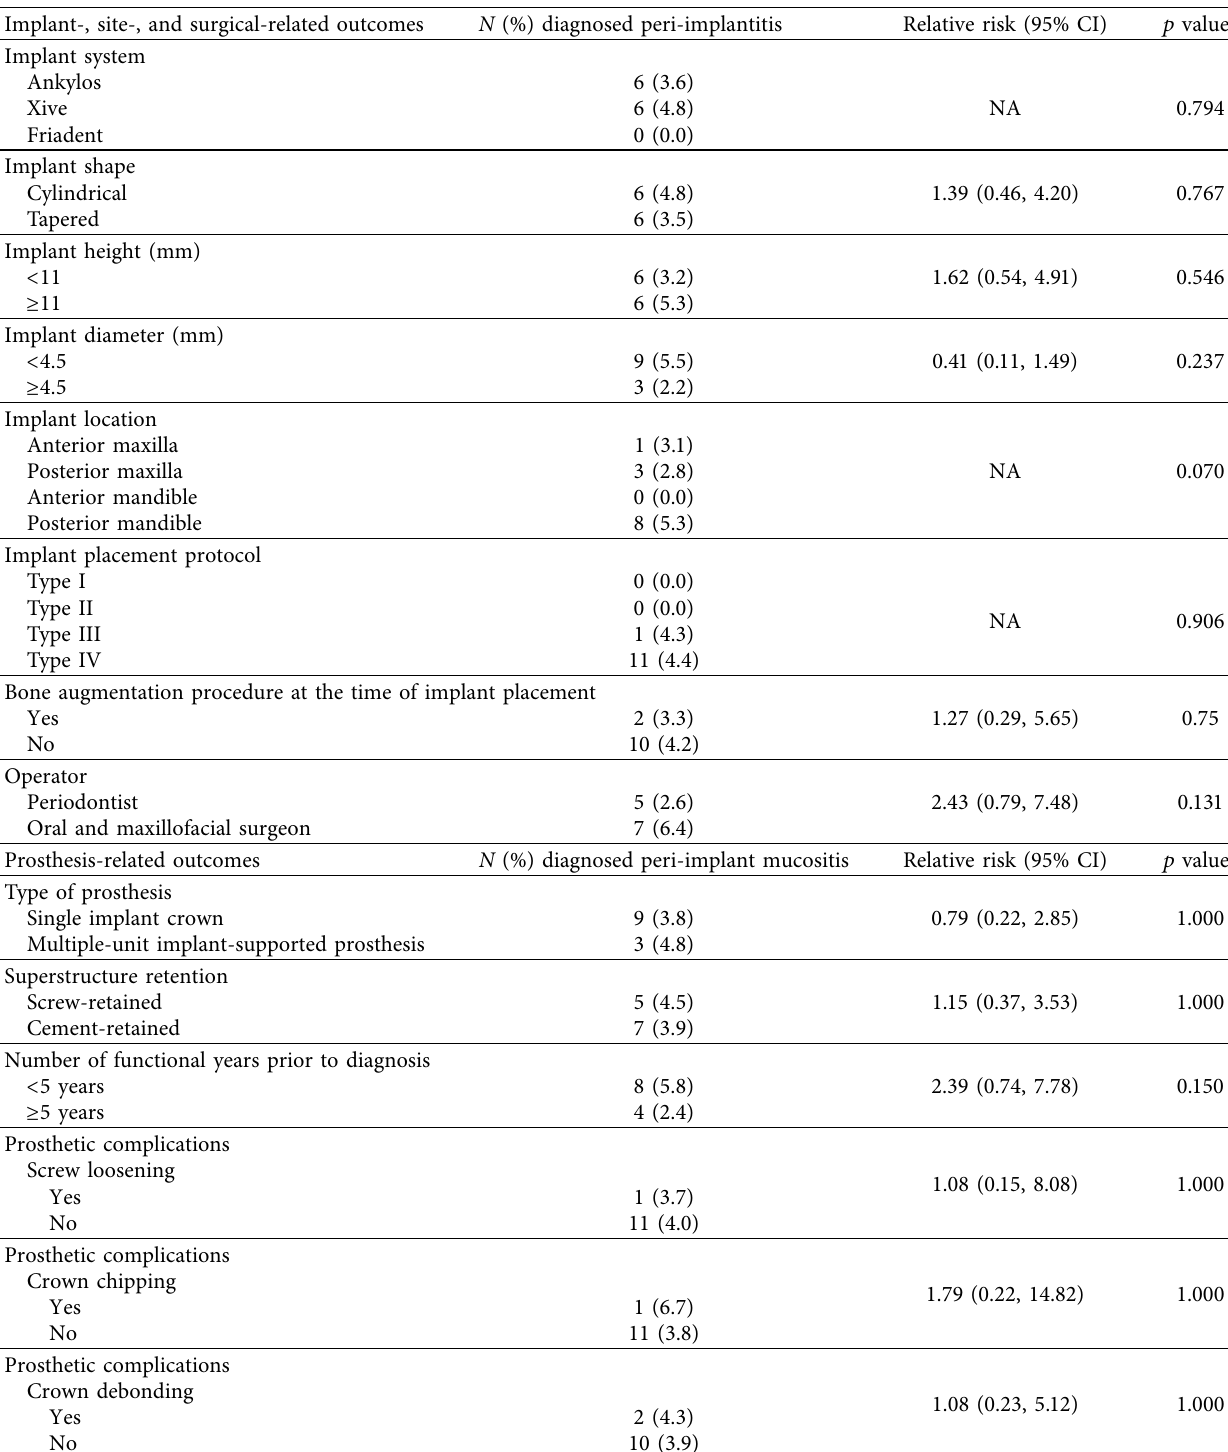
Table 4: Characteristics of implants diagnosed with peri-implantitis ( n � 301). Implant-, site-, and surgical-related